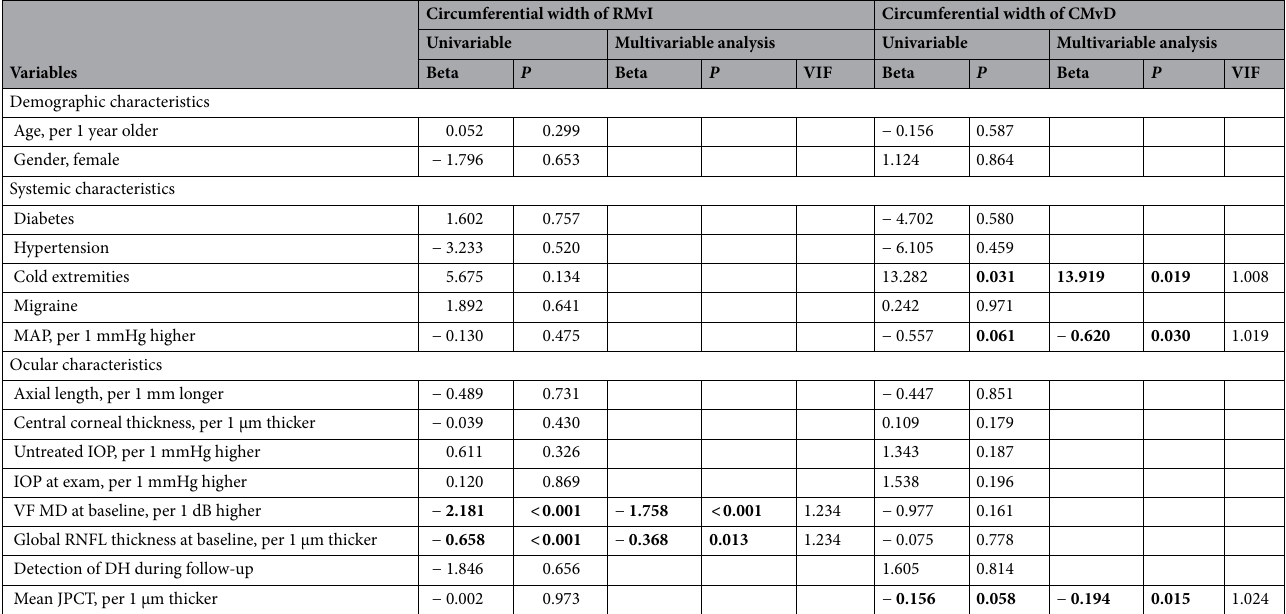
Table 2. Factors associated with the circumferential width of RMvI and CMvD in all POAG Eyes (n = 88). Variables with P < 0.1 in the univariable analysis were included in the multivariable analysis. Values with statistical significance are shown in bold. RMvI retinal microvascular impairment, CMvD choroidal microvascular dropout, VIF variance inflation factor, MAP mean arterial pressure, IOP intraocular pressure,